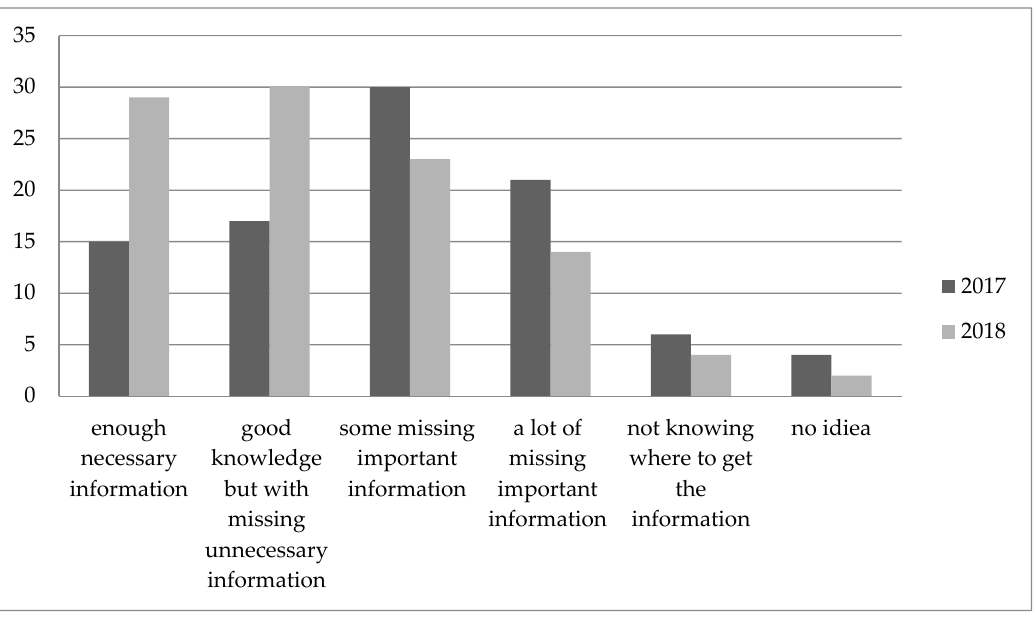
Figure 6. Availability of information in %. Source: own processing based on survey results.